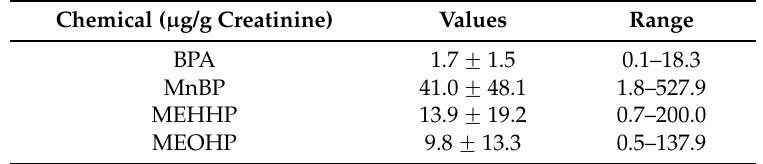
Table 2. Study population urinary BPA and phthalates concentrations a ( n = 305). Chemical ( µ g/g Creatinine) Values